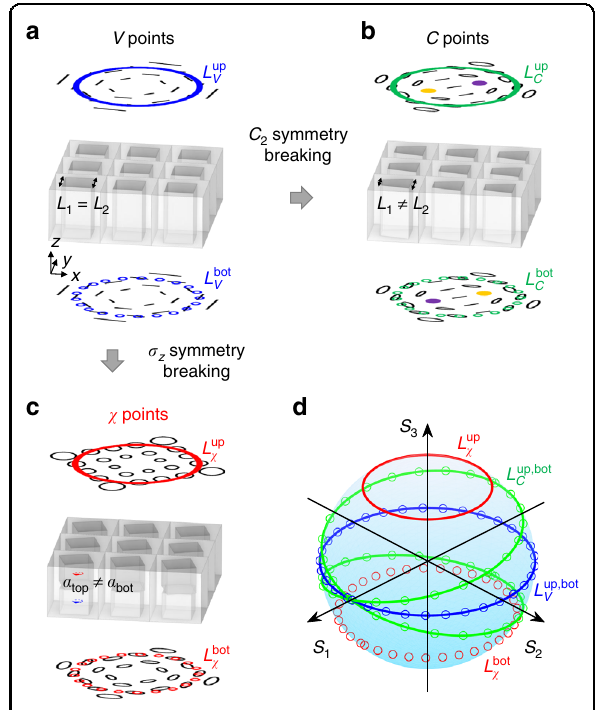
Fig. 1 Conventional σ z -symmetric and twisted photonic crystal slab (PhCS) supporting BICs at the Γ point. a Schematic of a conventional PhCS with etched square-hole standing in free space and its far- fi eld polarization states distribution in momentum space near the V point at BIC. b Breaking in-plane inversion symmetry of the PhCS results in elimination of BIC and two C points spawning from the V point. The radiation in upward and downward remains the same. c The twisted PhCS by rotating the top hole with an angle of α top . Breaking σ z -symmetry results in asymmetric radiation of elliptical polarizations surrounding BIC upward and downward. The BIC is rede fi ned as a χ point referring to arbitrary polarization states with the same ellipticity χ enclosing BIC. d Comparison of the polarization states on Poincaré sphere by enclosing the V point (blue line), C point (green line), and χ point (red line). The solid line and dash circles represent the encircling path in upward and downward direction,